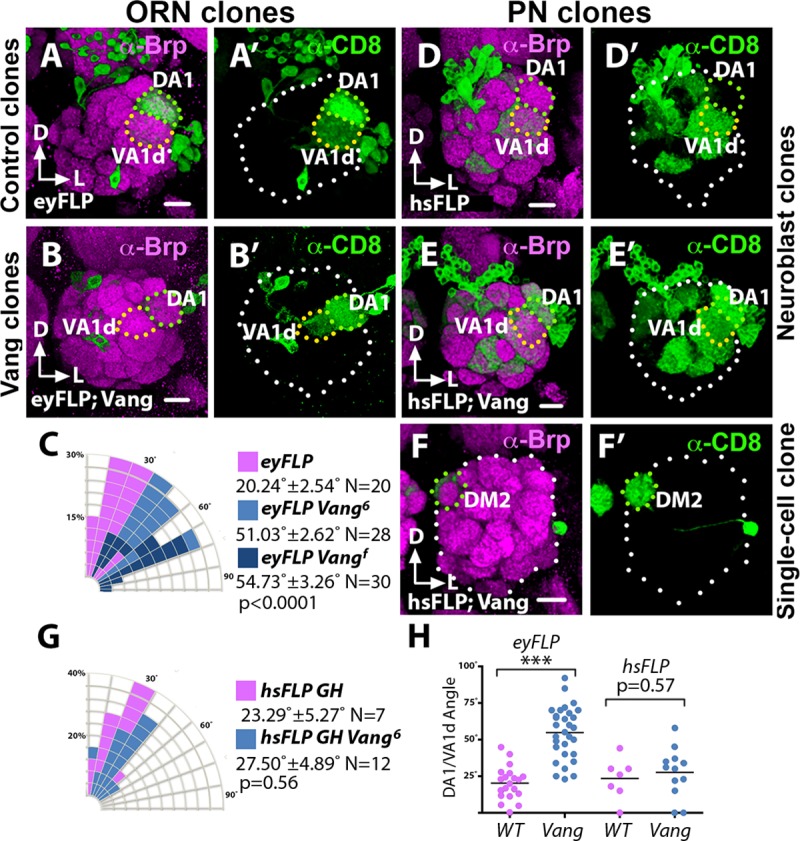
Vang functions selectively in ORNs but not the PNs to regulate glomerular migration.Vang6 and control mosaic ALs were stained with antibodies against Brp (Magenta) to visualize the glomerular pattern and CD8 (green) to visualize PN dendritic arborization. (A) In ALs innervated by wild-type ORN axon clones induced by the ey-FLP/FRT technique the DA1 glomerulus migrated normally relative to the VA1d glomerulus. (B) In ALs innervated by Vang6 mutant axon clones induced by the ey-FLP/FRT technique the DA1 glomerulus failed to migrate dorsally relative to the VA1d glomerulus. (C) Quantification of the glomerular angles in A and B. ANOVAs were used to simultaneously compare the control and the Vang6 and Vangf04290 conditions. (D) In ALs innervated by large clones of wild-type PN dendrites, induced by the MARCM technique the DA1 glomerulus migrated normally relative to the VA1d glomerulus. (E, F) In ALs innervated by neuroblast (E) and single-cell (F) clones of Vang6 PN dendrites induced by the MARCM technique, the mutant dendrites innervated the AL normally and the DA1 glomerulus migrated normally relative to the VA1d glomerulus. (G) Quantification of the glomerular angles in D, E and F. Student’s t test was used to compare the data of the mutant clones with that of the controls. (H) Graph summarizing the glomerular angles in the mosaic control and Vang6 ALs. Scale bars: 10 μm.